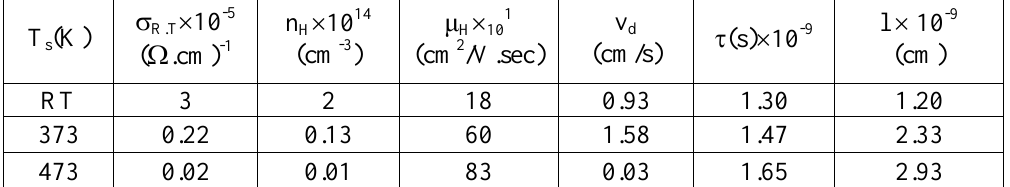
Table 5: Hall parameters for ZnO films at different annealing temperatures.